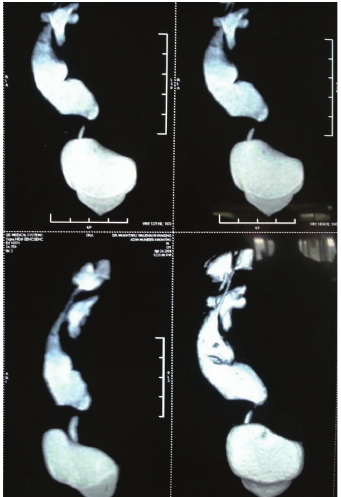
Figure 1: On the coronal MR urography image, the right ureter and the pelvicalyceal system are seen dilated.